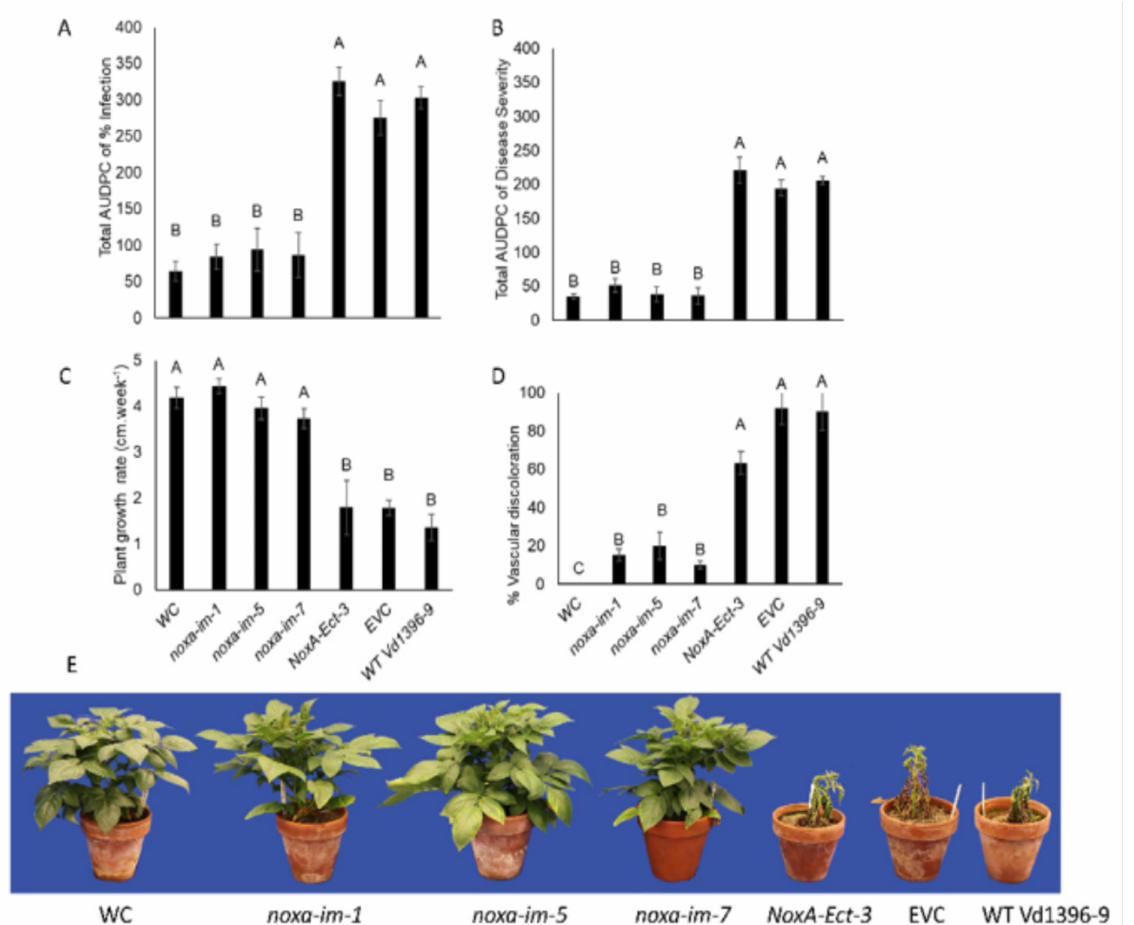
Figure 4. Pathogenicity test of noxa mutants on susceptible potato cultivar (Kennebec) in 2016. ( A ) Total AUDPC of percentage of infection. ( B ) Total AUDPC of disease severity. ( C ) Growth rate of potatoes. ( D ) Percentage of vascular discoloration. ( E ) Kennebec potatoes infected by noxa mutants at six weeks after infection. Error bars refer to standard error. The LSD post hoc test was performed to determine which differences are significant among the means. Bars ( n = 4) with different letters indicate significant differences ( p <